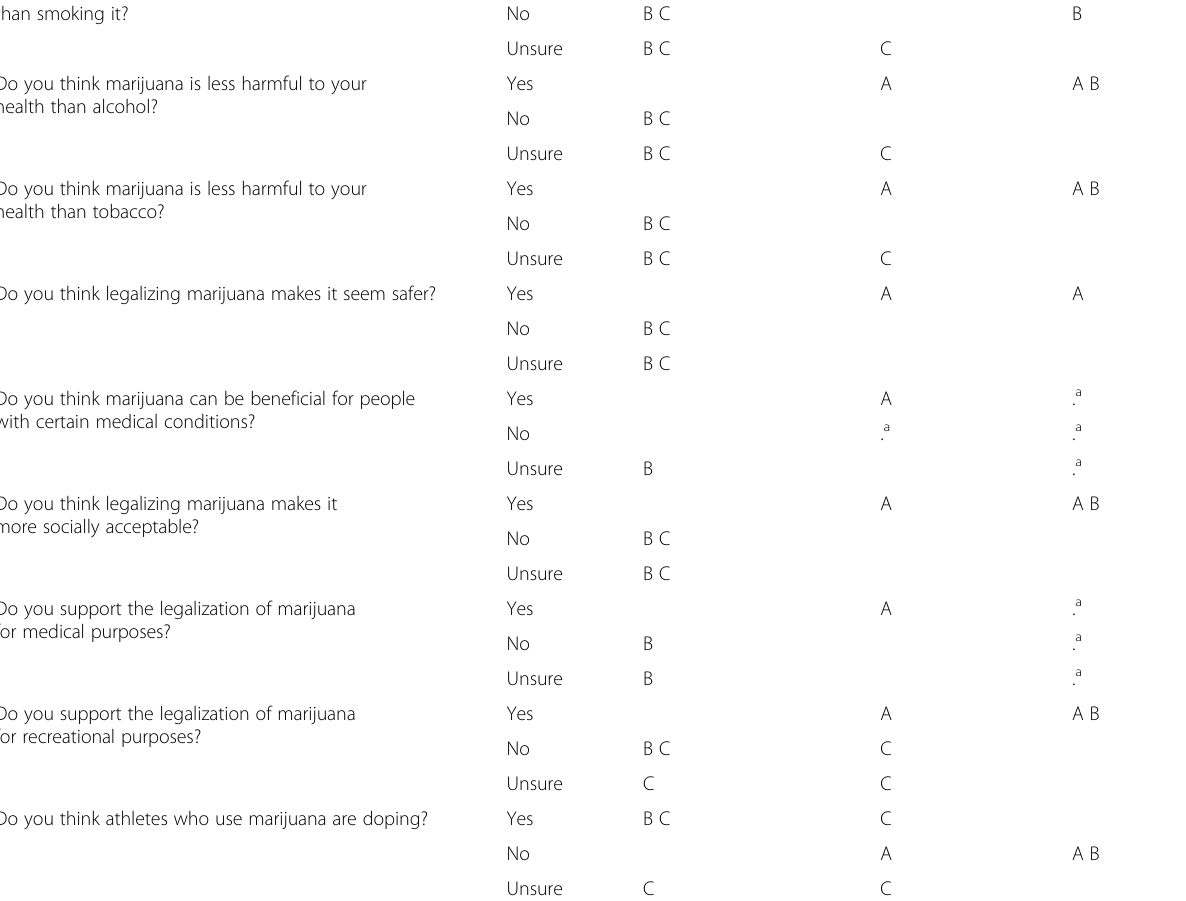
Table 2 Attitudes toward cannabis in adult athletes by cluster membership. [Data as N (%)] (Continued) than smoking